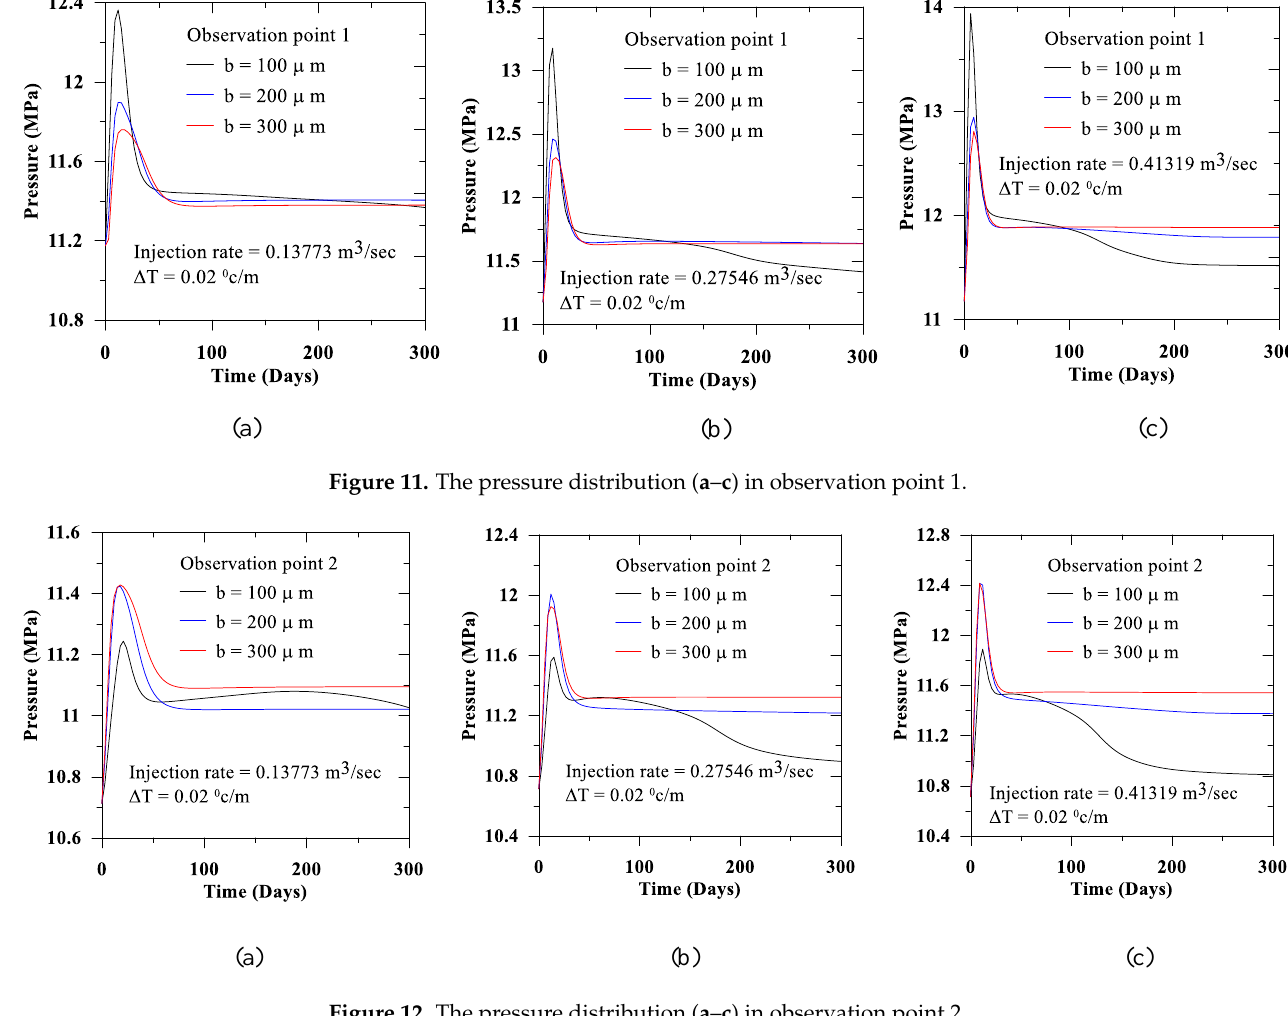
Figure 12. The pressure distribution ( a – c ) in observation point 2.